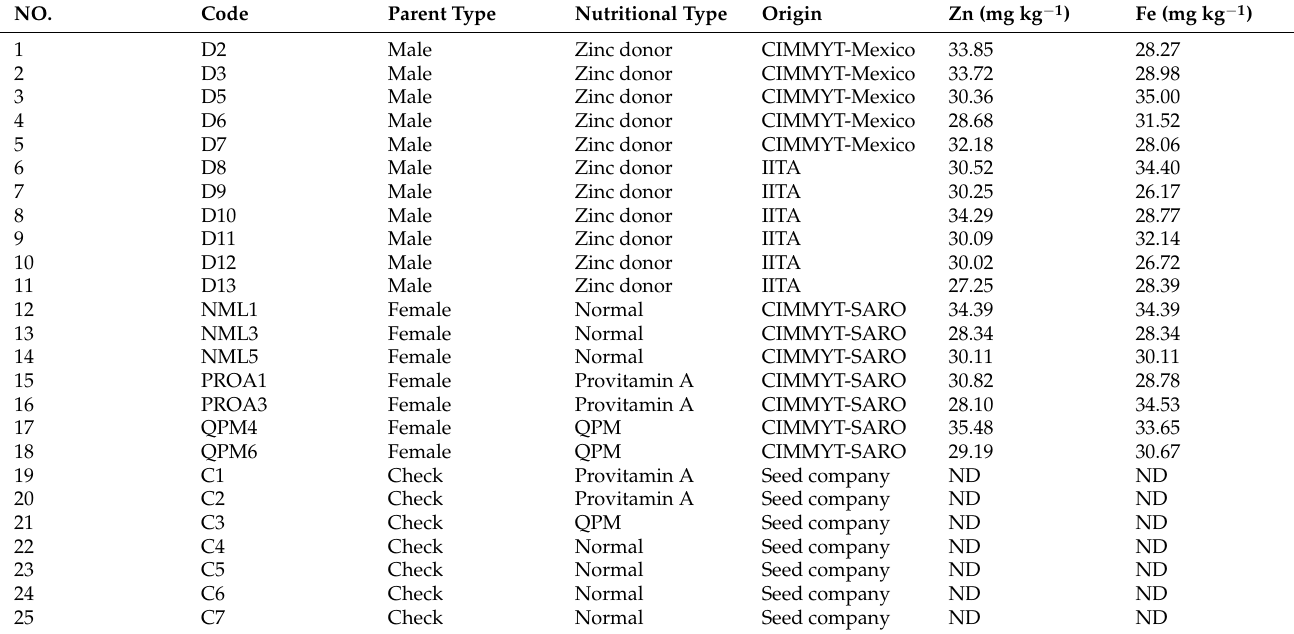
Table 6. Description of the selected plant materials used for making Zn-enhanced testcrosses and